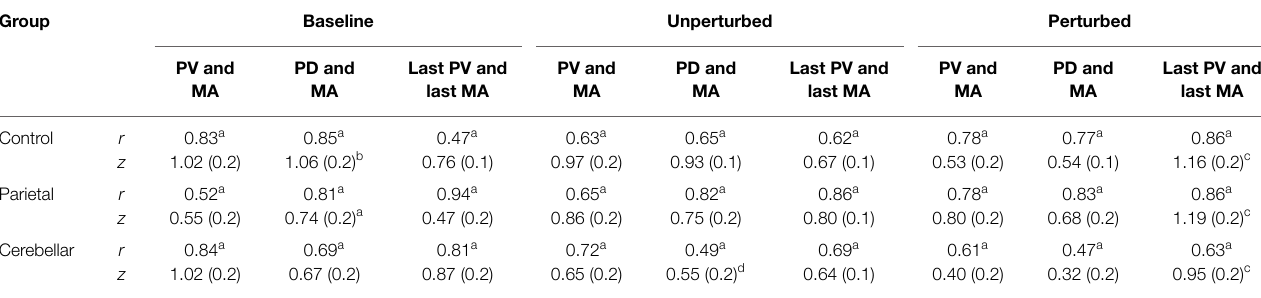
TABLE 4 | Pearson product-moment correlation r values and mean (SE) z scores, for correlations between (1) absolute times of peak velocity and maximum aperture; (2) absolute times of peak deceleration and maximum aperture; and (3) absolute times of the last peak velocity and the last maximum aperture . Group Baseline Unperturbed Perturbed